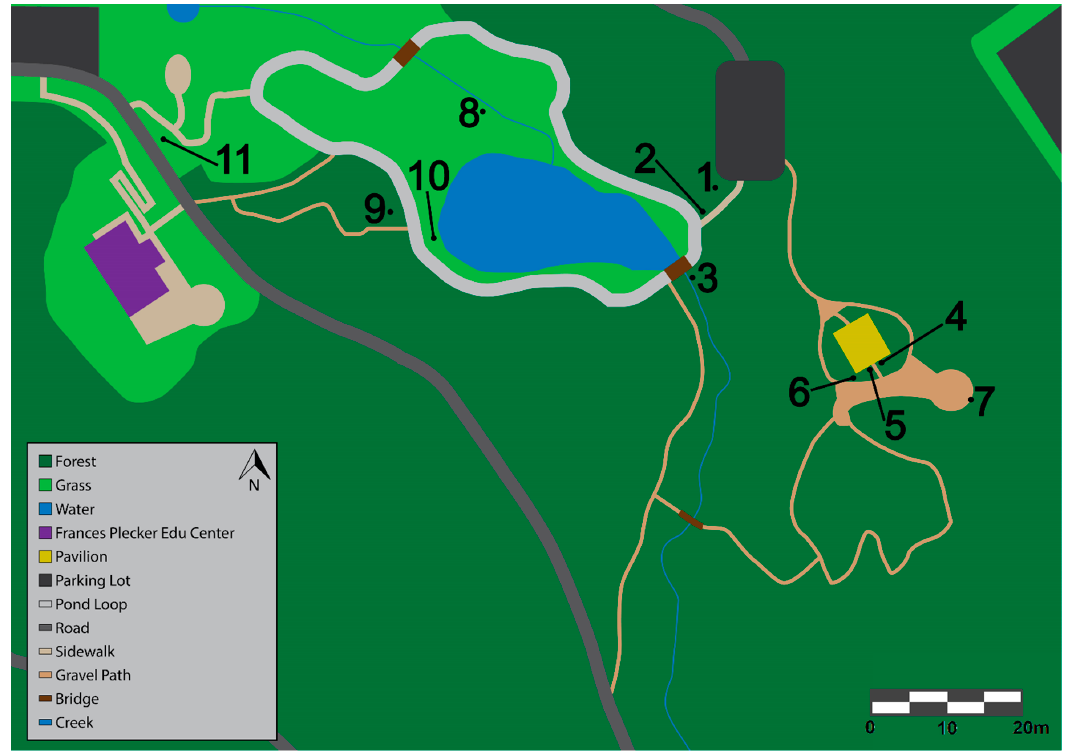
Figure 4. ArcGIS map designed digitized over a satellite image of the Edith J. Carrier Arboretum using Adobe Illustrator. The GPS data of the samples collected along the arboretum trails were used to locate the samples on the map (Table 2). Legend: 1. shale; 2. shale; 3. quartzite; 4. quartzite; 5. dolomite; 6. quartzite; 7. quartzite; 8. dolomitic limestone; 9. dolomite; 10. quartzite; 11. dolomite. Table 2. GPS location of the sample analyses.